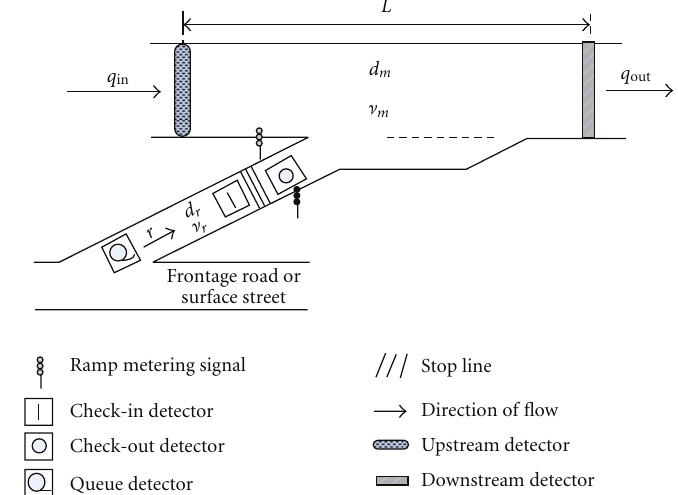
Figure 3: Reinforcement learning ramp metering model.